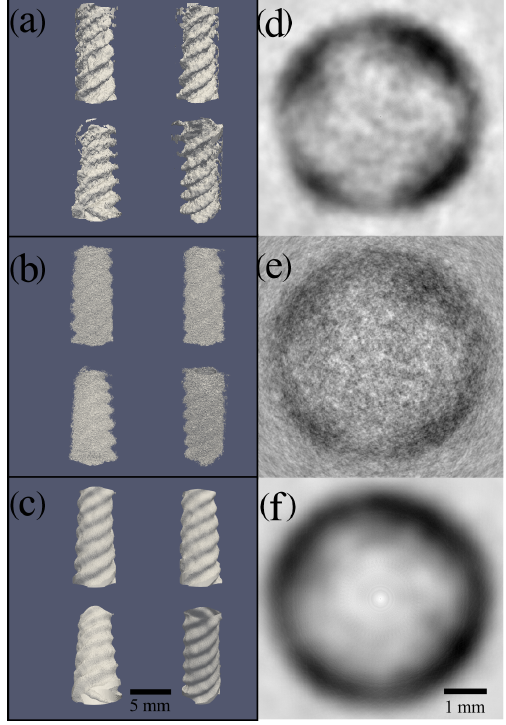
Figure 2. Comparison of reconstructed 1 H-NMR spin noise tomo- grams of the phantom immersed in H 2 O / D 2 O (9:1) recorded at 700MHz obtained with three different processing procedures from the same raw data. The acquired signal originates from the water protons around the solid phantom, which is not observable due to the extremely broad lines of the polymer. Total noise data recording time was 40h. (a–c) Four different views for each processing proce- dure visualized as iso-surfaces representing the boundary between liquid and solid. (d–f) Comparison of density plots of ( X – Y ) a 2D cross section extracted from the center (along the Z direction) of the corresponding 3D image of the 1 H noise magnitude signal (white representing zero amplitude and black the maximum magnitude). Panels (d) , (e) and (f) display 2D cross sections of the 3D images shown in panels (a) , (b) and (c) , respectively. (a, d) Images ob- tained by our new iterative reconstruction processing using combi- nations of different time-domain sliding window sizes (as described in the main text). (b, e) Images processed with the standard pro- jection reconstruction algorithm (Andersen and Kak, 1984), using a time-domain sliding window size of 1024 data points (correspond- ing to 103ms), resulting in high resolution but a low signal-to-noise ratio (contrast). (c, f) Images processed with standard projection re- construction using a time-domain sliding window size of 128 data points (corresponding to 13ms), resulting in low resolution and a higher signal-to-noise ratio